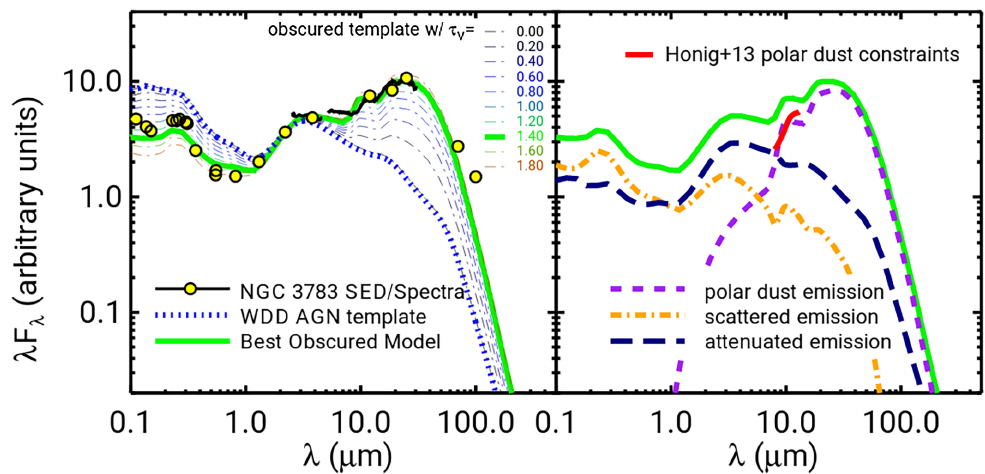
Figure 6. ( Left ): the observed UV-to-far-IR SED of NGC 3783 as traced by high-resolution data (yellow circles), with the SED model from Lyu & Rieke [12]. ( Right ): the contributions of various components of the best-fit model as a function of wavelength. The 8–13 µ m polar dust emission from Hönig et al. [70] is also shown for comparison. The Lyu & Rieke [12] model obscures the intrinsic AGN template with an extended dust distribution and calculates the resulting SED, which includes three components—(1) attenuated emission of the input SED, (2) scattered, and (3) polar (i.e., reprocessed) emission from this obscuring dust component, through radiation